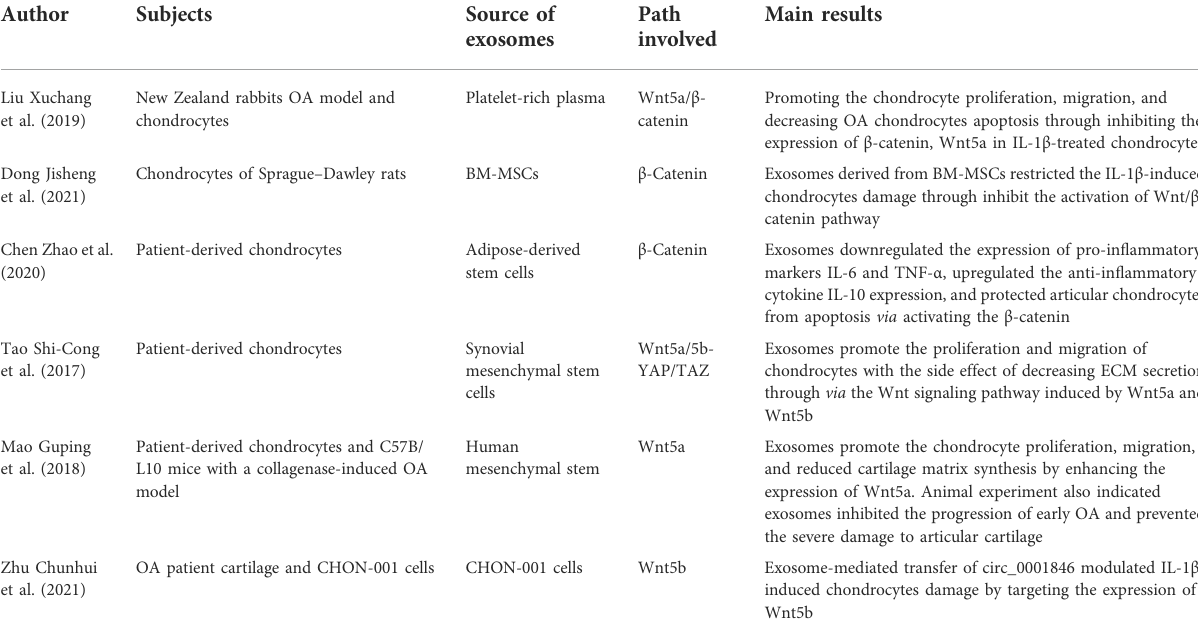
TABLE 2 | Role of the exosome and Wnt in